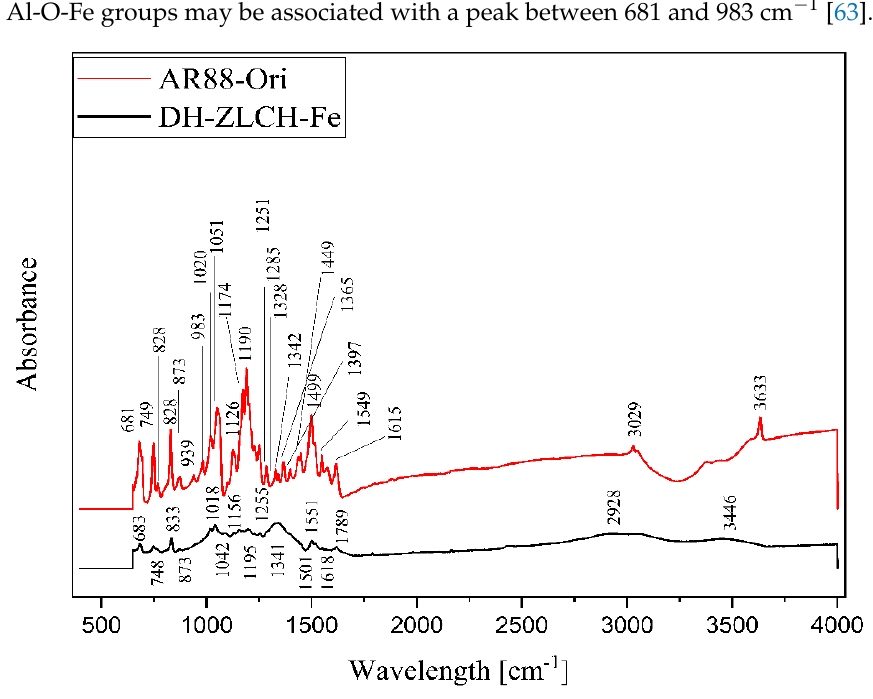
Figure 14. ATR-FTIR spectra of the AR88-Ori and DH-ZLCH-Fe.